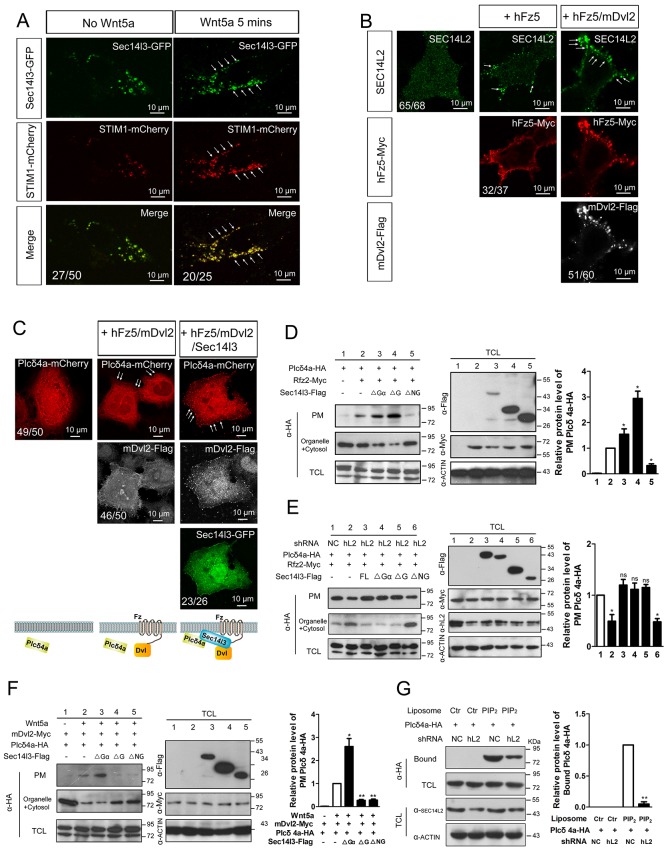
PM zone enriched-Sec14l3 recruits PLC for activation upon Wnt5/Fz stimulation.(A) Co-localization of Sec14l3 (green) with STIM1 proteins (red) in PC3 cells with or without Wnt5a stimulation. Arrows indicates PM-localized protein after Wnt5a stimulation. Scale bar, 10 μm. (B) Immunofluorescence of endogenous SEC14L2 in HEK293T cells with or without hFz5/mDvl2 transfection. Arrows indicates PM-localized SEC14L2 (green). Scale bar, 10 μm. (C) Immunofluorescence of Plcδ4a-mCherry (red), mDvl2-Flag (gray) and Sec14l3-GFP (green) in MCF7 cells. PM-localized Plcδ4a (red) are indicated by arrows. The bottom panel show the schematic representation of transfected constructs in corresponding rows and an interpretation of the results. Scale bar, 10 μm. (D) The Sec14l3 CARL-TRIO and GOLD domains are important for Rfz2 mediated Plcδ4a recruitment to the PM in the HEK293T cells. Statistical data from three independent experiments are presented as mean ± SEM on the right (*p<0.05; ns, non-significant; same for other statistical data below). (E) Rfz2-mediated Plcδ4a PM recruitment is abolished in stable SEC14L2-knockdown HEK293T cells and failed to be restored by Sec14l3-ΔNG overexpression. Statistical data are presented. (F) The Sec14l3 GOLD domain is important for Wnt5a mediated Plcδ4a recruitment to the PM in PC3 cells. Statistical data are presented. (G) SEC14L2 depletion perturbs Plcδ4a access to PIP2. Equal amounts of purified Plcδ4a protein and liposomes with or without PIP2 were incubated with control or SEC14L2 depleted cell lysates. Statistical data are presented. All numerical data represented as a graph in the figure are shown in Figure 5—source data 1.DOI:
http://dx.doi.org/10.7554/eLife.26362.01810.7554/eLife.26362.019Figure 5—source data 1.Numerical data for graphs in Figure 5 and Figure 5—figure supplement 1.